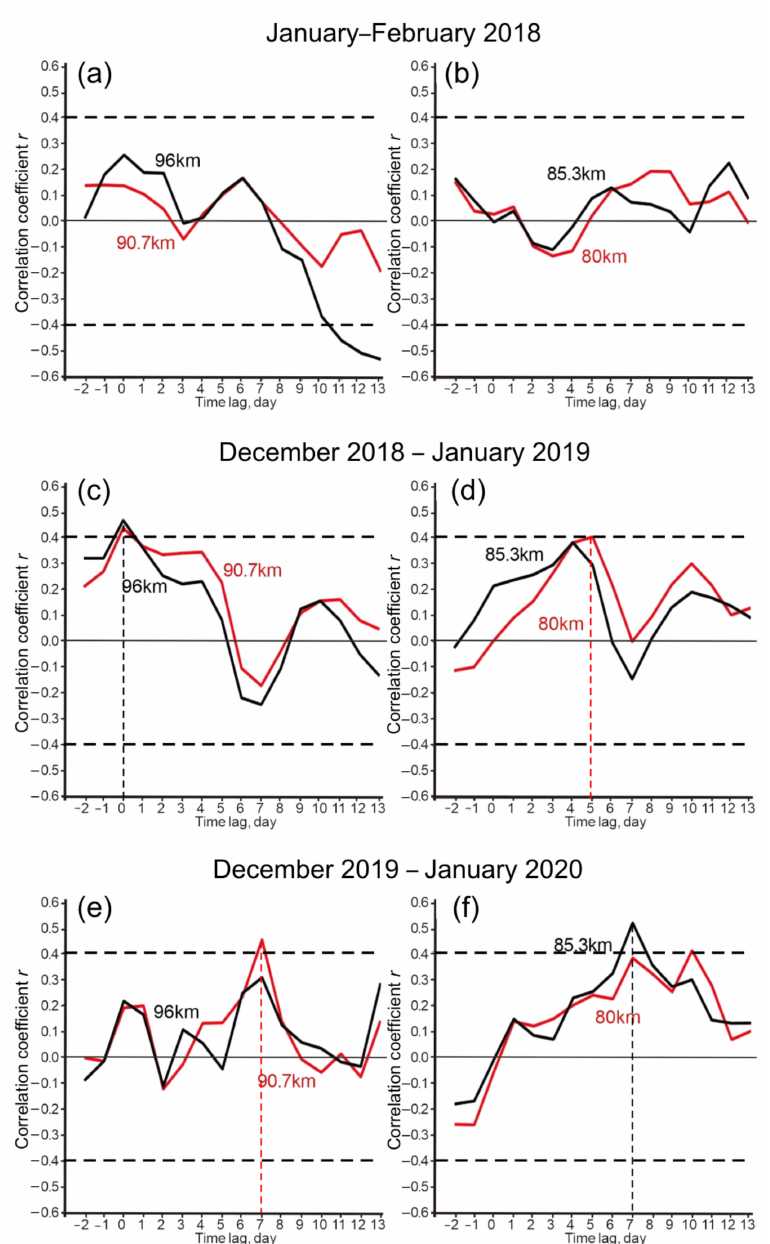
Figure A2. Moving correlation between amplitudes of zonal wave 1 (Z1) and wave 2 (Z2) at 50 ◦ N in the mesosphere–mesopause region (80, 85, 91, and 96 km). The MLS data for boreal winters of ( a , b ) 2018, ( c , d ) 2018/2019, and ( e , f ) 2019/2020 are presented. Dashed horizontal lines show the 95% confidence limits, and dashed vertical lines indicate maximum correlations reaching or exceeding the positive confidence